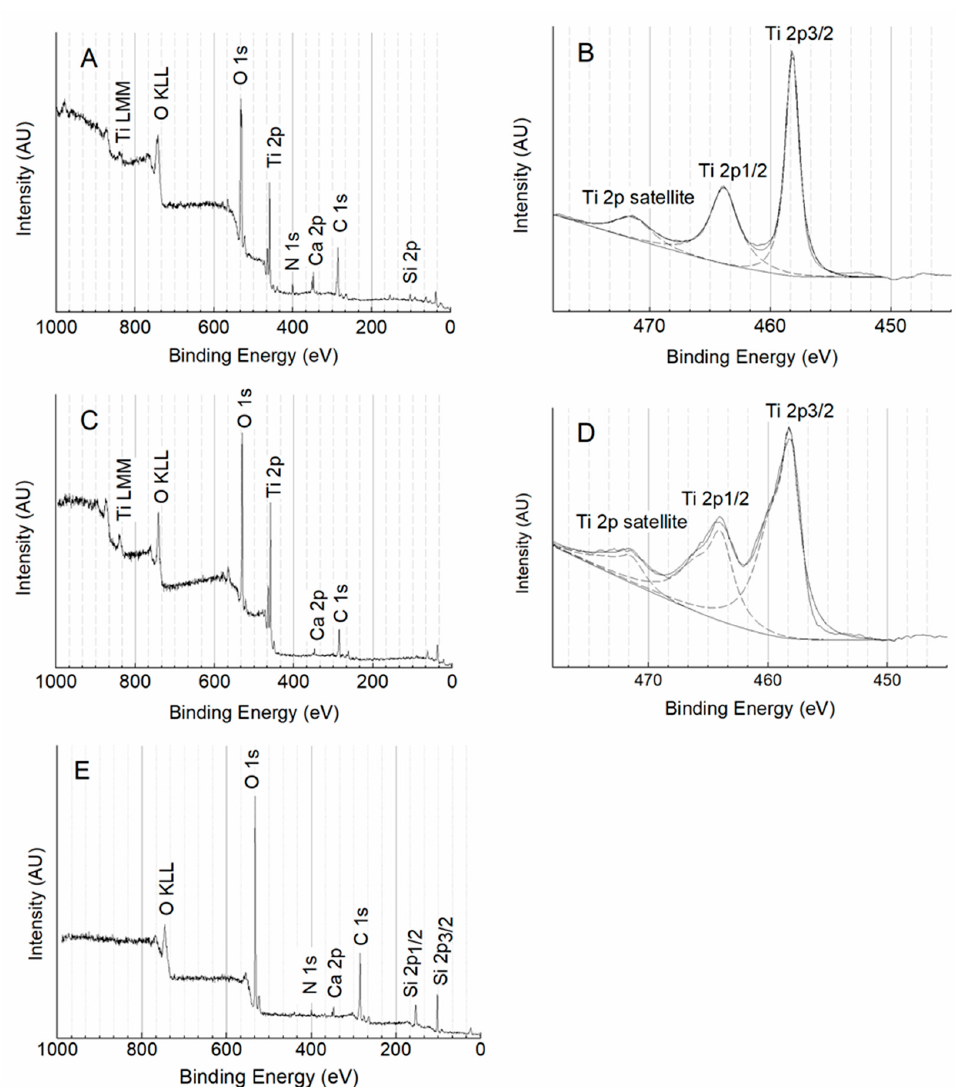
Figure 2. XPS survey spectra of SaniTise™ ( A ), BIOCLEAN ® , ( C ) and reference (uncoated side of BIOCLEAN ® glass) ( E ); Ti 2p high-resolution spectra of SaniTise™ ( B ) and BIOCLEAN ® ( D ). Dotted lines represent the spectral components of experimental spectra obtained by fitting. XPS photoelec- tron lines are marked as element symbol and respective core level. Auger peaks are marked as ele- ment symbol and Auger transition series. Spin orbitally split Ti 2p photoline sub-bands are marked as Ti 2p 3/2 and 2p 1/2 . The TiO 2 shake up satellite is marked as well.